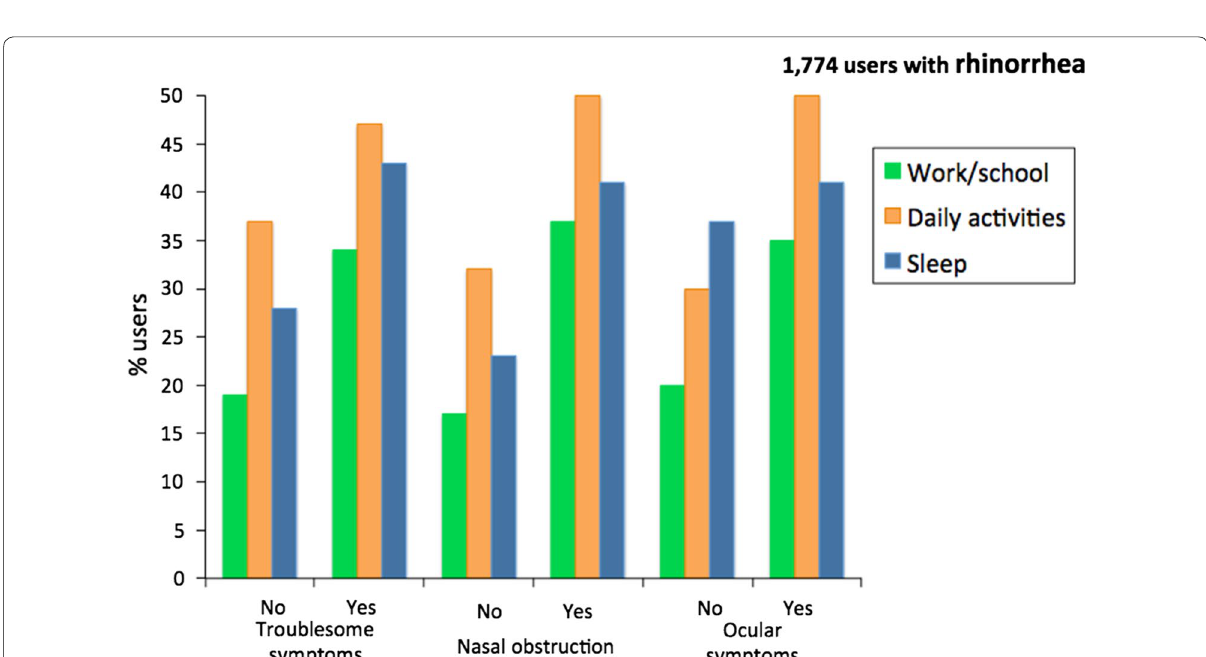
Fig. 8 Impact of symptoms on work, school and daily activities (from Bousquet et al.